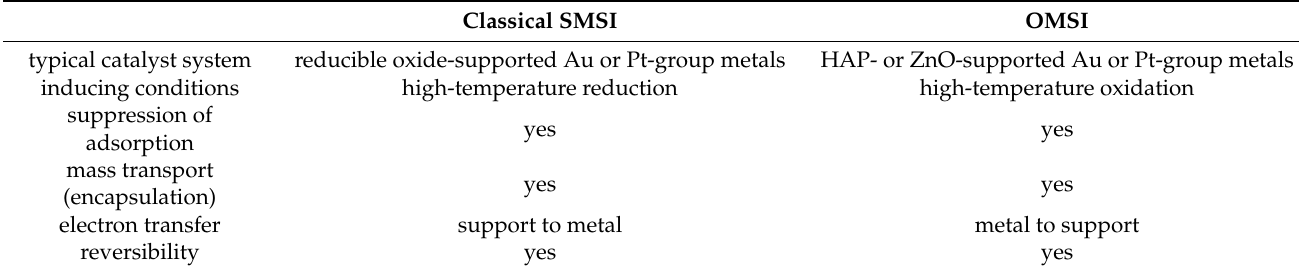
Table 1. Comparison between OMSI and classical